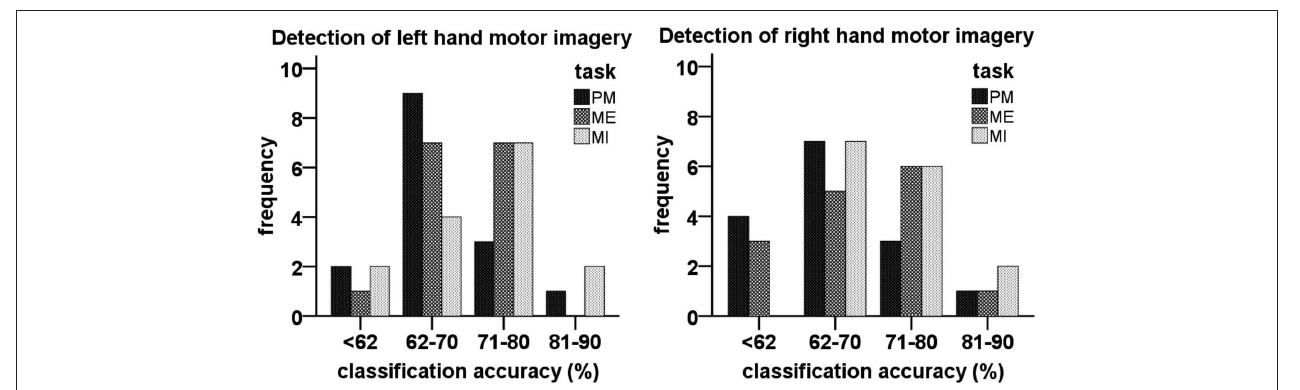
Figure 6 | Histogram of classification accuracies for different classifiers.